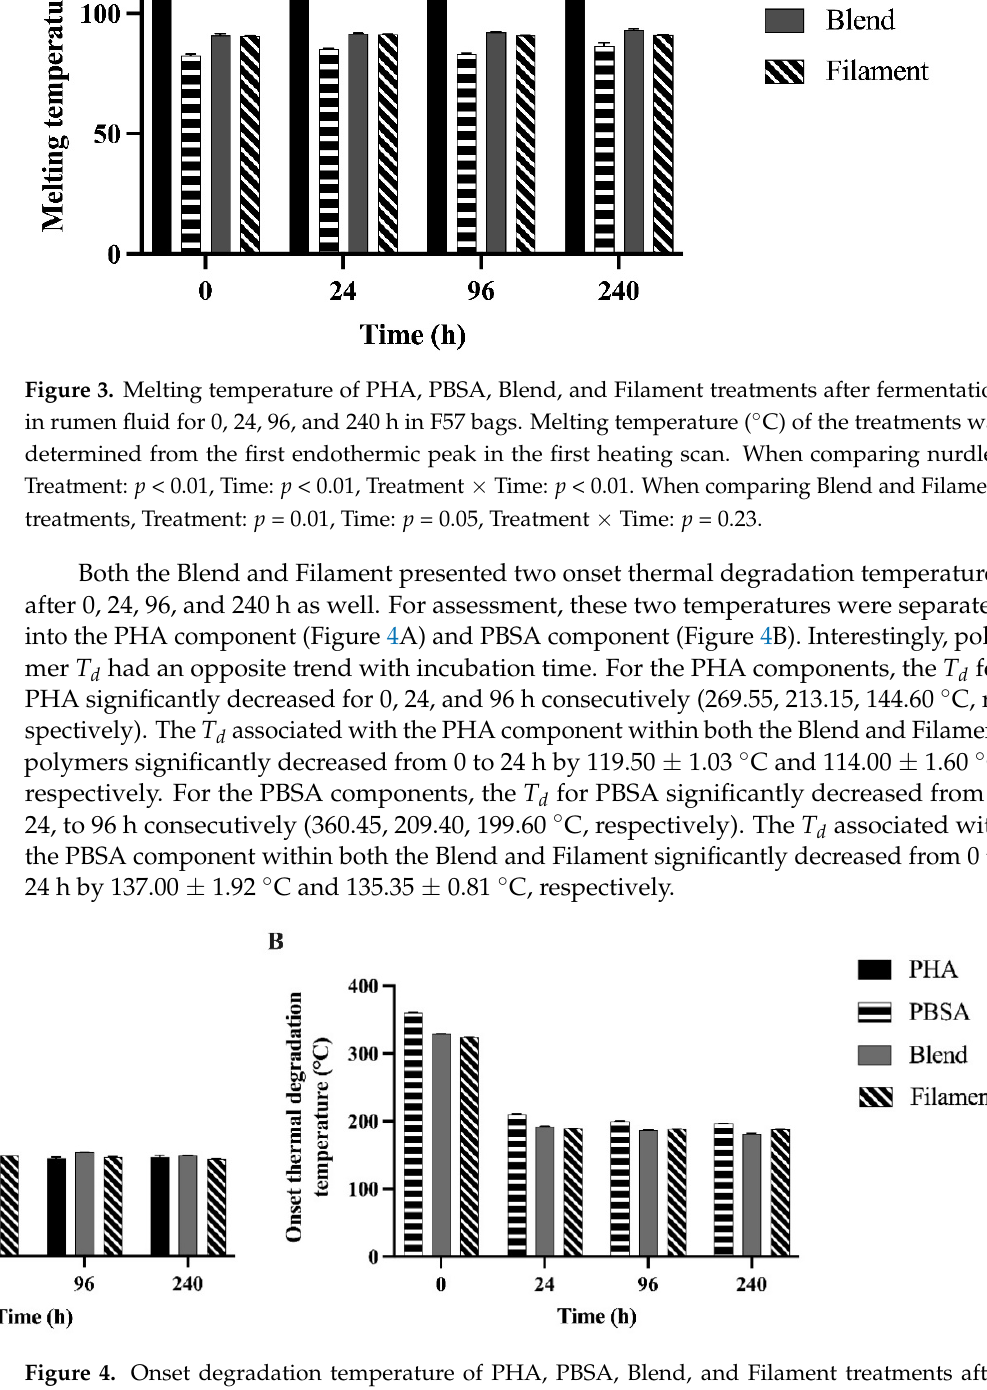
Figure 5. Intrinsic viscosities of PHA, PBSA, and Blend treatments after fermentation in rumen fluid for 0, 24, and 240 h in F57 bags. 4. Discussion Repetitive administration of oral drugs due to their release times induces stress to the animal by additional handling. Other potential materials should be identified and studied to replace current slow-release bolus carriers that last only three to five months [8]. Polyhydroxyalkanoates are viable materials to investigate as they are biodegradable by several genera of bacteria [6,14]. Known bacteria that produce extracellular enzymes that hydrolyze these materials largely belong to the Proteobacteria phylum, which is abundant in the rumen [9,18–23]. With the abundant microbial community, elevated tem- perature, slightly acidic pH, and consistent motility in the rumen, the ruminal environ- ment is presumed to foster degradation of PHA-based materials and blends with PBSA. This is the first study to specifically evaluate the ability of a ruminal environment to breakdown a PHA-based polymer and PBSA. Proprietary PHA-based polymer nurdle, PBSA nurdle, and a melt blend of the two in nurdle and filament form underwent fermen- tation for up to 10 days in rumen fluid in Daisy II Incubators. Mass loss of residues was